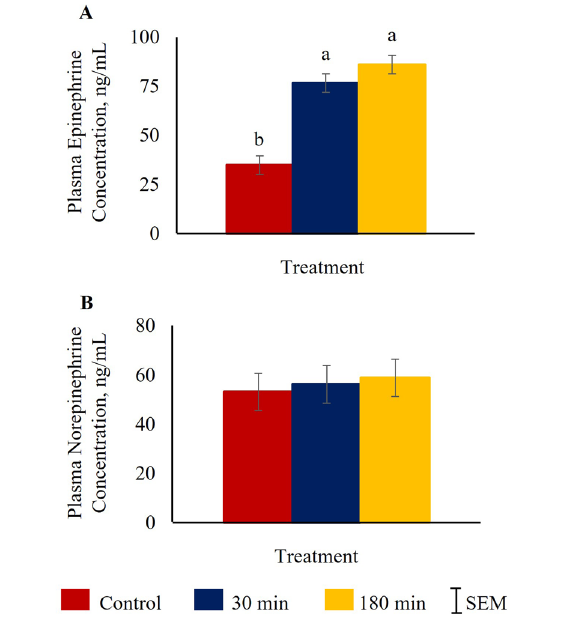
Figure 1. Effects of stress treatment (Control = not transported but held in pens; 30 min = transported for 30 min; 180 min = transported for 180 min) on mean ± SEM plasma ( A ) epinephrine and ( B ) norepinephrine concentrations in